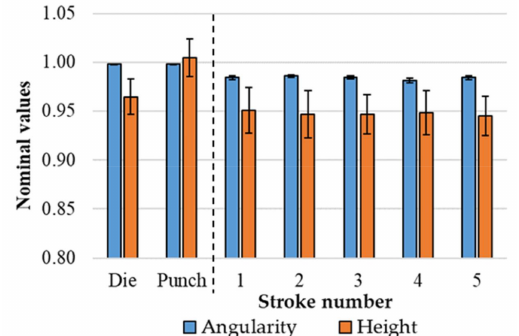
Figure 13. Normalized measurements of workpiece and tool feature